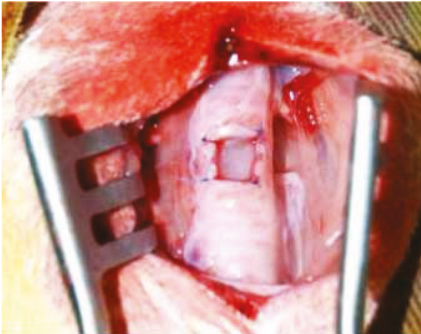
Figure 4: SIS group: defect covered by a rectangular graft supported by four points in the vertices with polypropylene 4.0.